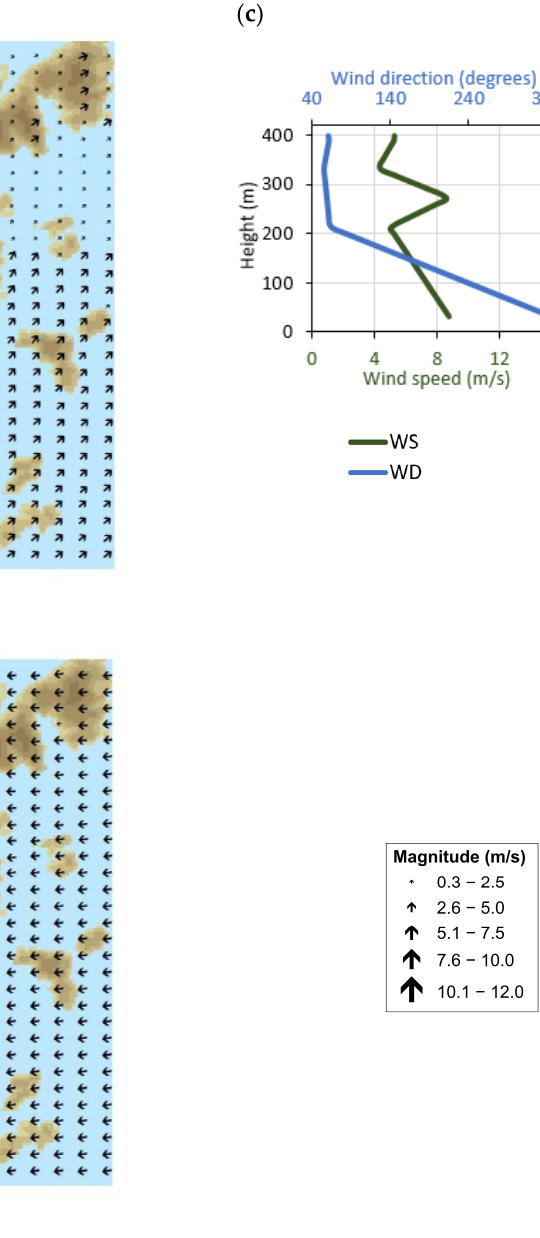
Figure 9. Calculated flowfield for 13:05 2 February 2018 at ( a ) 100 m above ground and ( b ) 200 m above ground. The inset ( c ) shows the observed vertical wind-speed (WS) and -direction (WD) profiles at CCH.